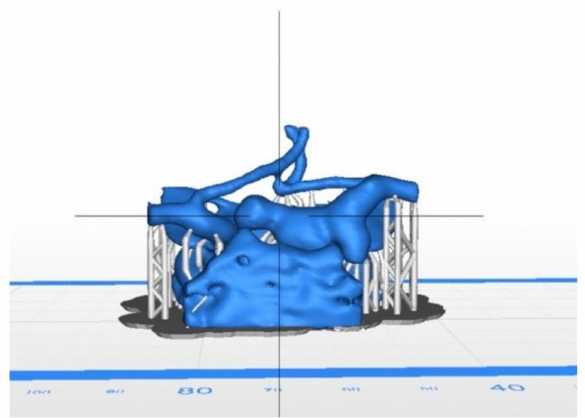
Figure 2. STL format in Z-Suite software.